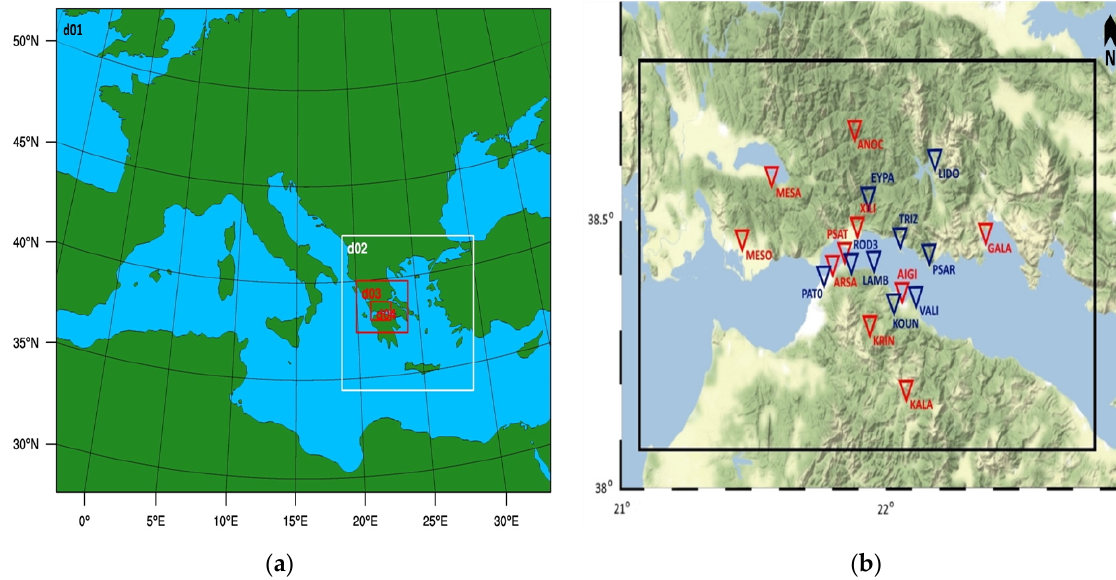
Figure 1. ( a ) Left, map showing the four nested domains (d01-d04) used for WRF weather re-analysis over the Western GoC. ( b ) Right, map of the PaTrop study area, Western GoC. Previously installed permanent GNSS stations are marked in blue colour, newly installed GNSS stations marked in red colour. The black box indicates the location of the 1 × 1 km inner domain of the WRF re-analysis run (Domain d04).